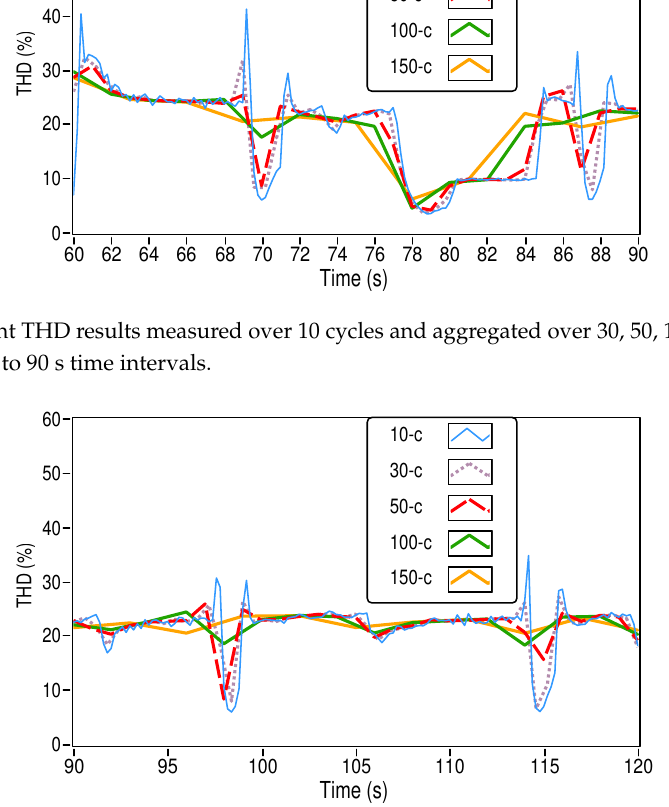
Figure 10. Current THD results measured over 10 cycles and aggregated over 30, 50, 100 and 150 cycles representing 90 s to 120 s time